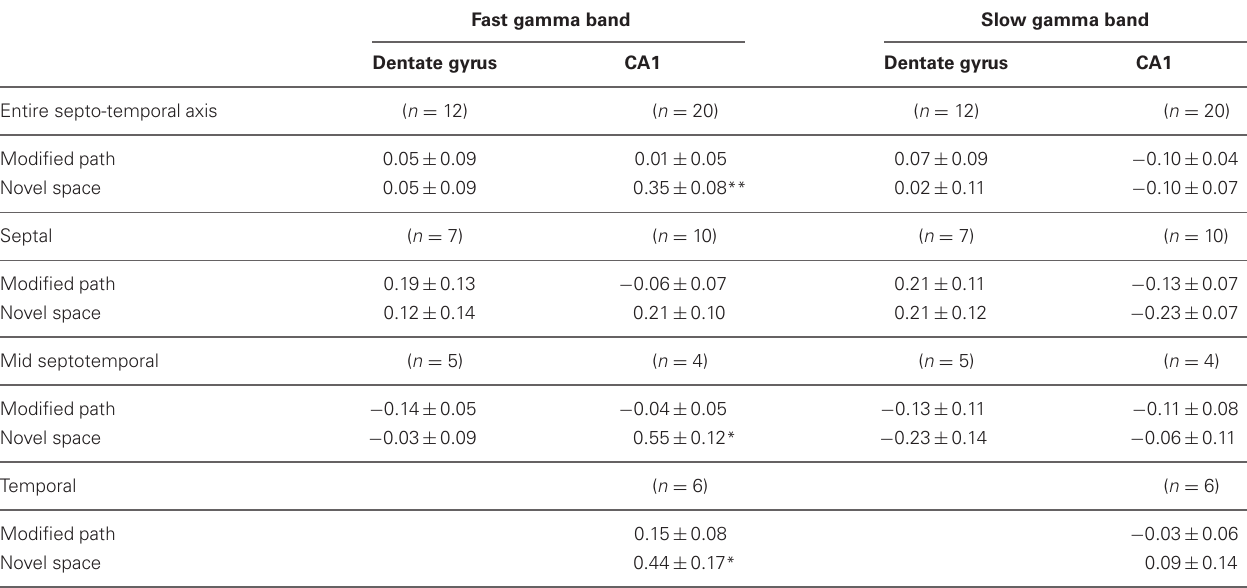
Table 1 | Gamma coherence by septotemporal